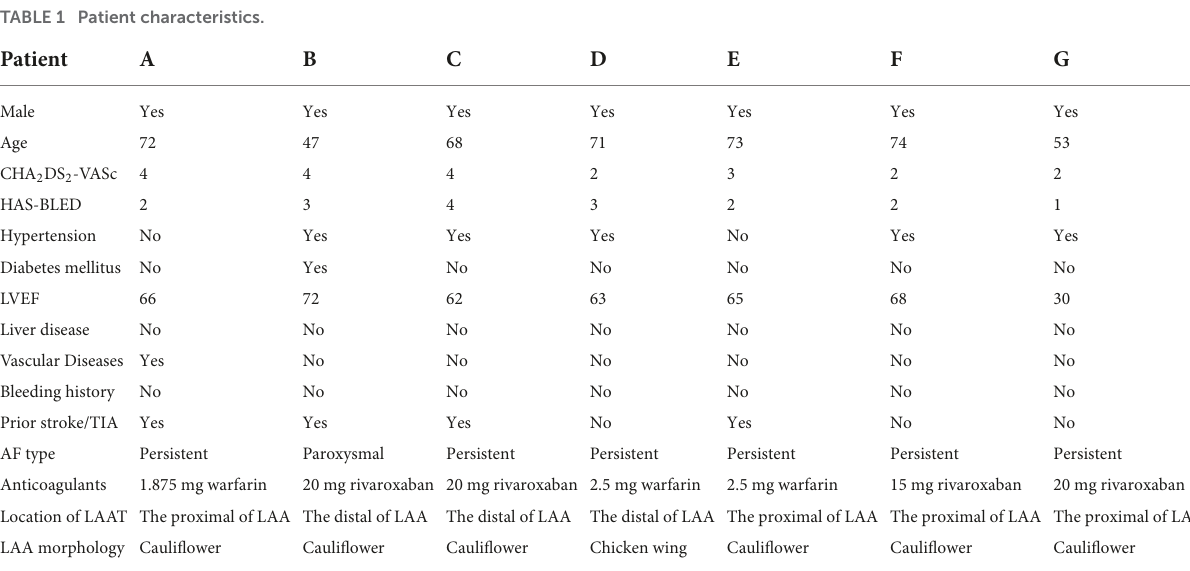
TABLE 1 Patient